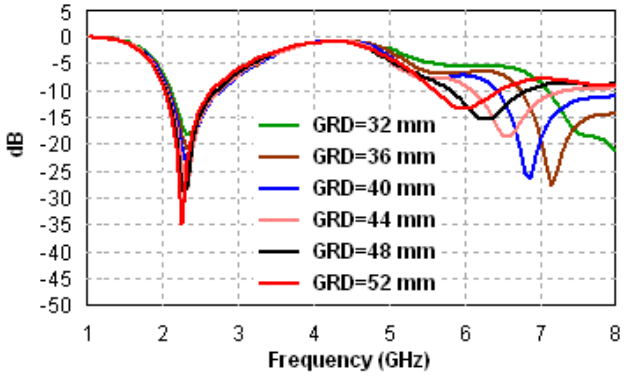
Figure 8: The S 11 responses of the 3rd iteration Koch fractal monopole antenna of Figure 6(a) with GRD as the parameter